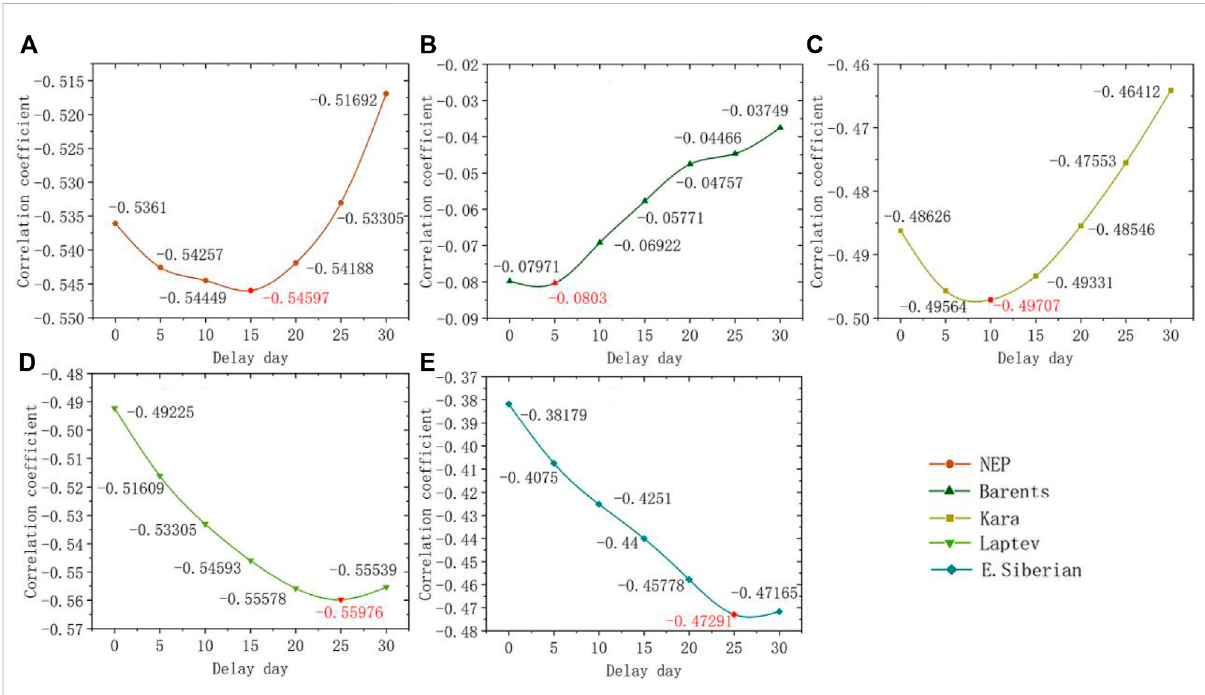
FIGURE 10 Graphs showing the correlation coef fi cient between the precipitation increase and the decrease in SIC plotted against the length of delay in days for (A) the NEP, (B) Barents Sea, (C) Kara Sea, (D) Laptev Sea, and (E) East Siberian Sea. All of the correlation coef fi cients passed the signi fi cance test ( p < 0.01).